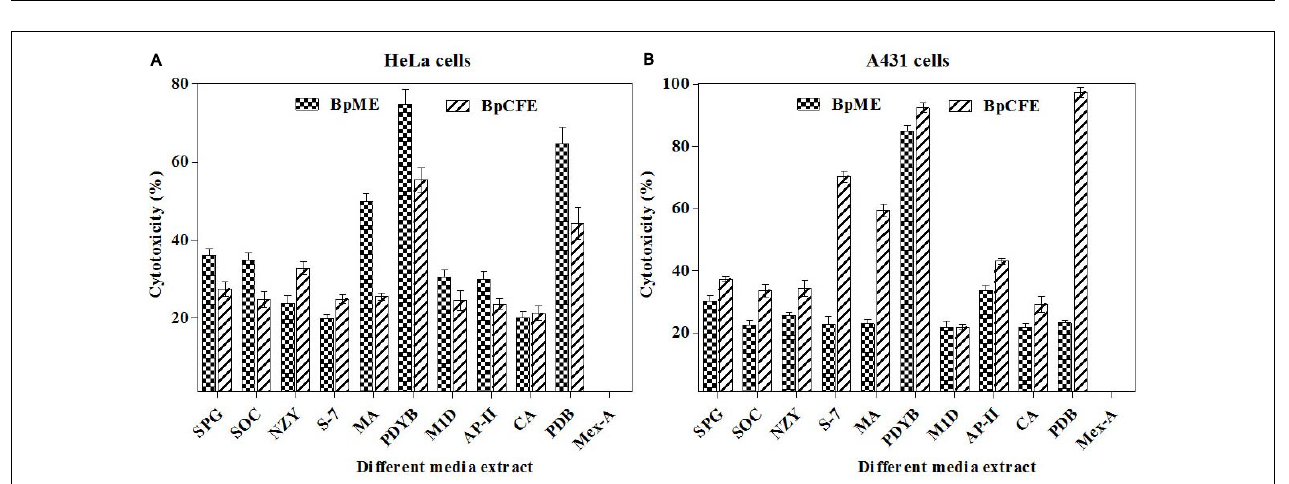
FIGURE 4 | Morphological observation of Biscogniauxia petrensis . The colonies at 7 days of inoculation on potato dextrose agar (PDA) plate front (A) and rear (B) view, respectively. (C) Appearance of red droplets at 10–14 days of growth on PDA plate. (D) Growth of B. petrensis in PDYEB at 21 days of culture. (E–G) Light microscopy image of the B. petrensis spores ( × 40 magnification) and microscopy image of chlamydospore.